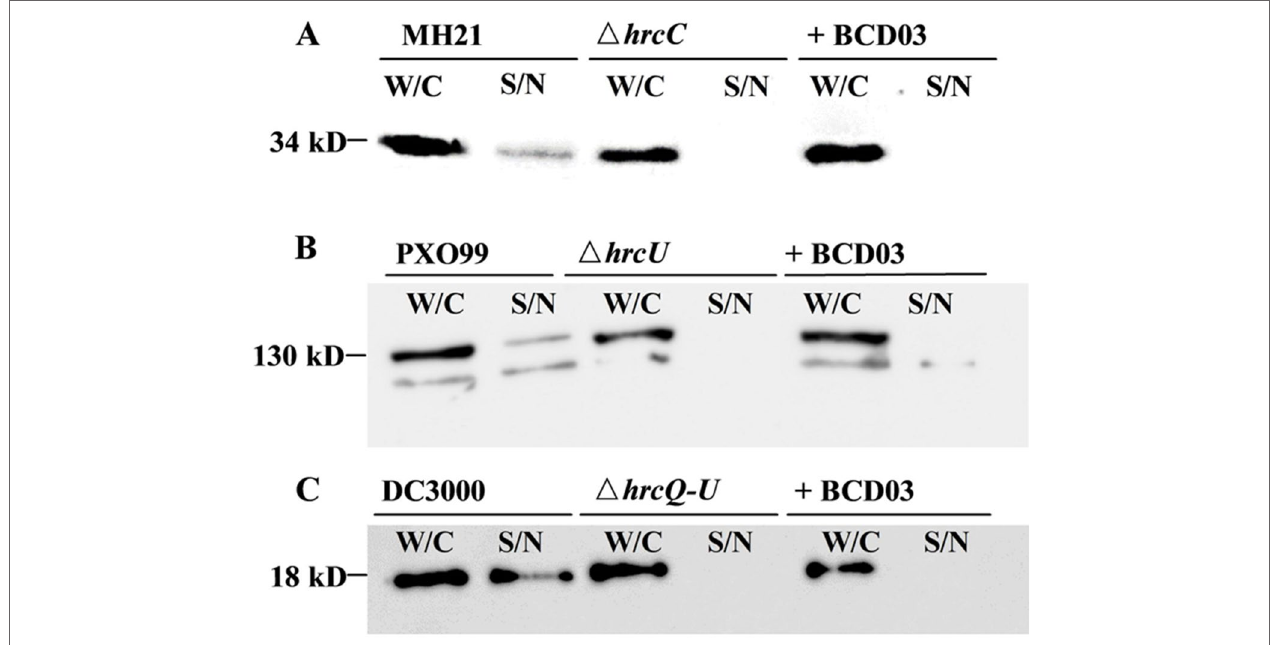
FIGURE 4 | BCD03 inhibition of effector secretion via bacterial T3SS. (A) A. citrulli MH21 bearing the hopAO1 -FLAG construct. (B) X. oryzae pv. oryzae PXO99 A bearing the avrXa27 -FLAG construct. (C) P. syringae pv. tomato DC3000 bearing the avrPto -HA construct. All bacteria were grown for 8 h in their own hrp -inducing media with or without BCD03 at a finial concentration of 25 µg/mL. Whole cell extracts (W/C) and supernatants (S/N) were separated by centrifugation, and their secreted proteins were detected with anti-FLAG or anti-HA